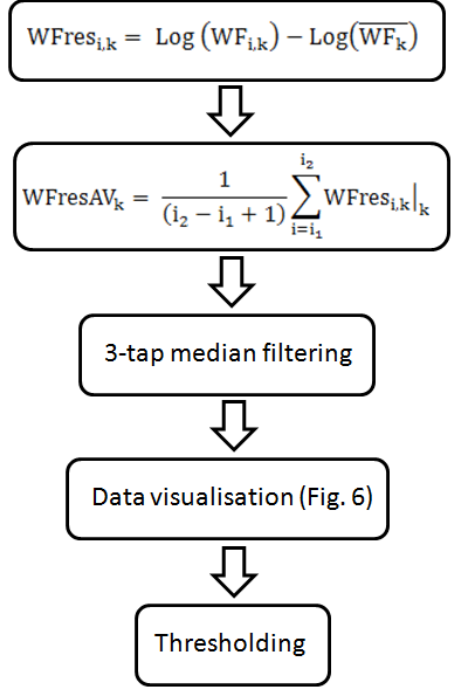
Figure 5. Flow diagram summarizing the procedure for identifying the gates corresponding to non-ocean scatterers. WFres i,k stands for the “waveform residuals” being calculated as the distance between each waveform and their reference (in Log scale). WFresAV k stands for the average of adjacent waveforms identified as “anomalous”. Indices i 1 and i 2 indicate, respectively, the first and last waveform residual considered.